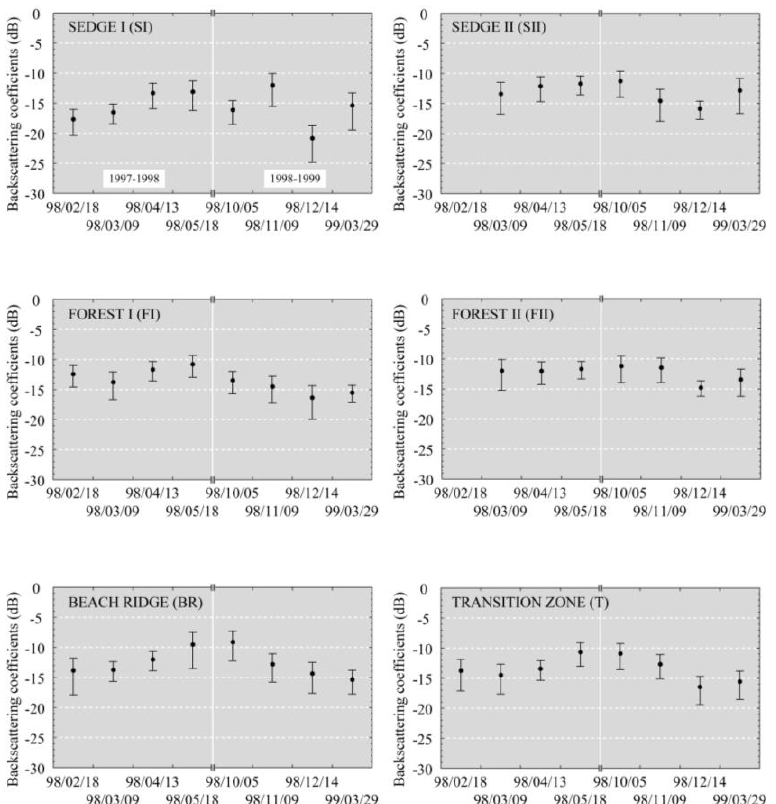
Figure 9. The ERS-2 seasonal backscatter signatures at six sampling sites. Shown are the maximum, mean, and minimum backscattering coefficients for a 5 × 5-pixel subset